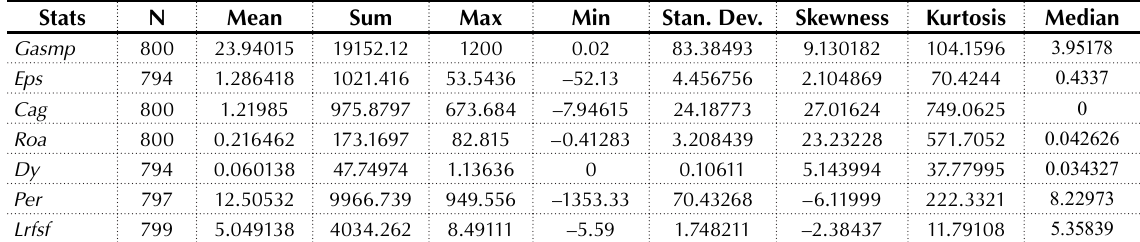
Table 1. Descriptive statistics (Growth Stock Portfolio)